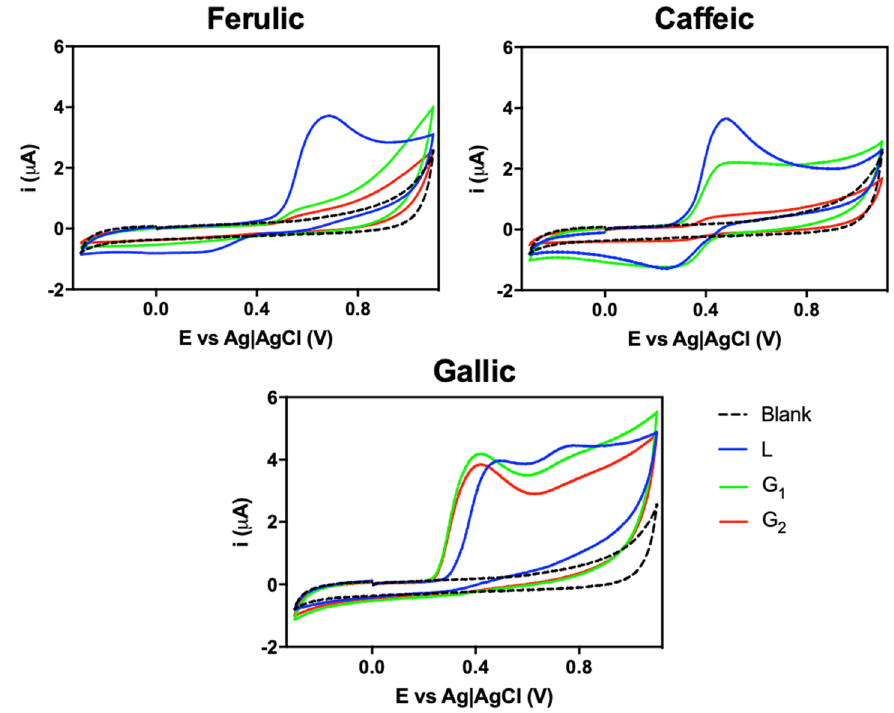
Figure 6. Cyclic voltammograms of polyphenols and their dendritic derivatives ( 1 – 6 ). For more experimental details, see Section 2.3.